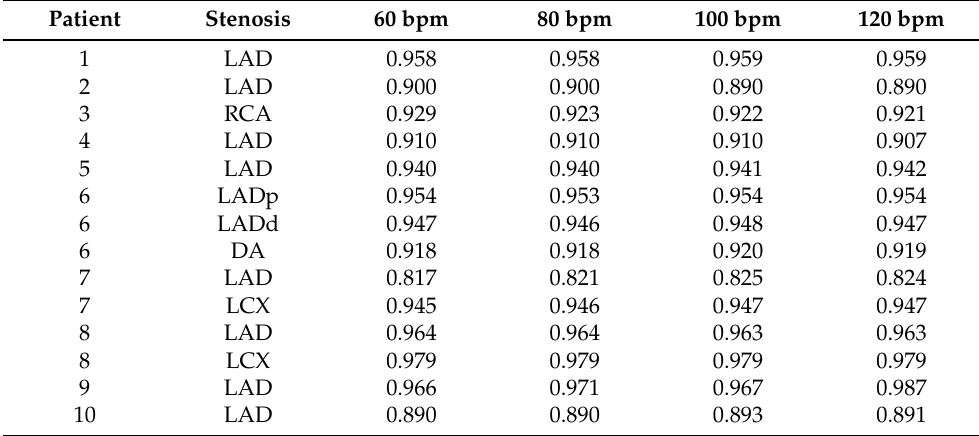
Table A4. iFR values for various heart